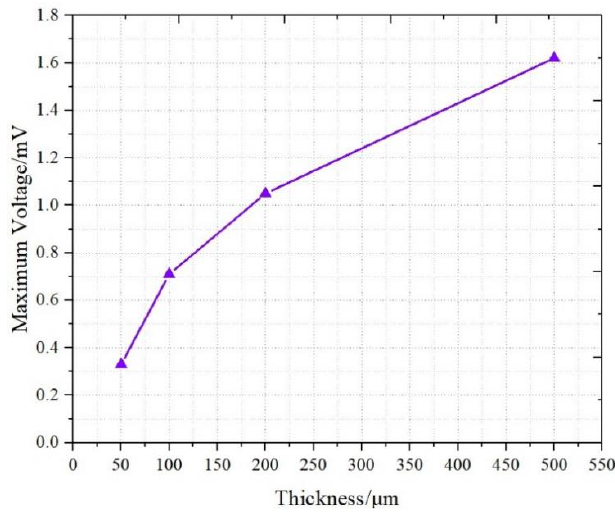
Figure 8. Signals of different thicknesses.